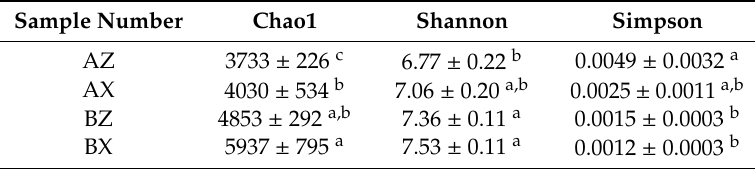
Table 2. Bacterial microbial-diversity index of plantation forest litter and original forest litter.